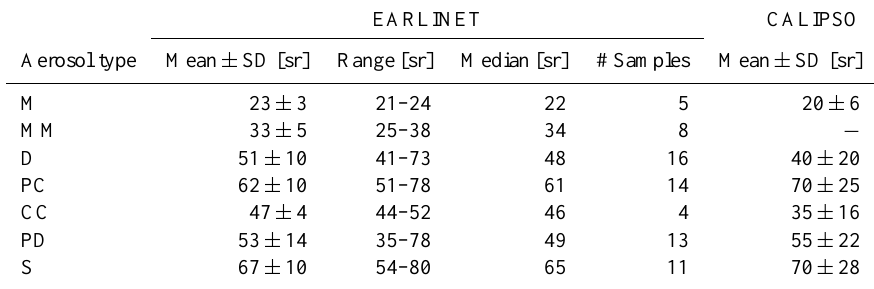
Table 5. Mean lidar ratio at 532nm for the different aerosol subtypes as measured by EARLINET sites and corresponding statistical param- eters. The last column refers to the lidar ratio values assumed by CALIPSO and their associated lidar ratio distributions (mean plus standard deviation). M stands for marine, MM for mixed marine, D for dust, PC for polluted continental, CC for clean continental, PD for polluted dust, and S for smoke subtype. Note that, here, the M subtype corresponds to pure marine particles EARLINET